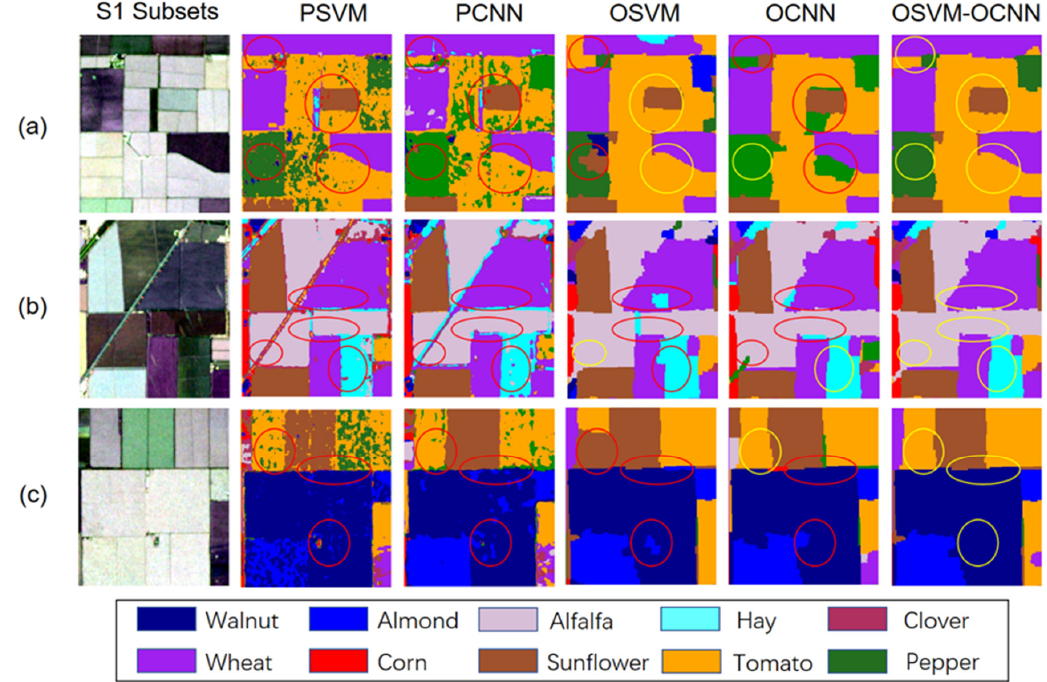
Figure 6. Three representative subsets ( a – c ) from the UAVSAR imagery with the corresponding classification maps; the first column shows the UAVSAR images (bands VV, HV and HH), the following columns illustrate the classification maps achieved by the PSVM, PCNN, OSVM, OCNN, and the proposed OSVM-OCNN, respectively; the regions with correct and incorrect classification results were labelled with yellow and red circles, respectively.